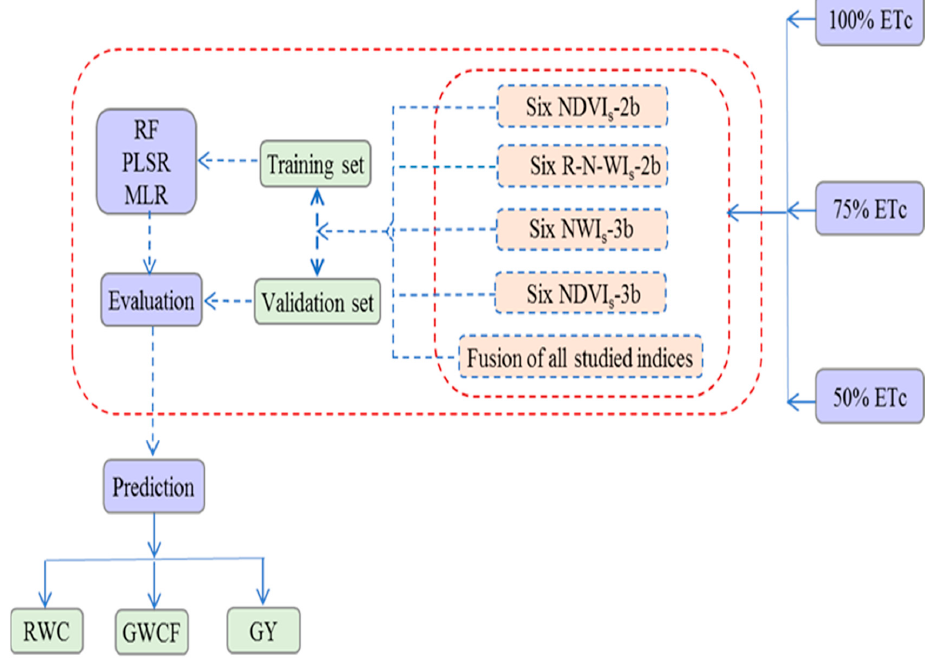
Figure 1. Flowchart showing a general overview of the methodology proposed for indirectly estimating the leaf water status and grain yield.